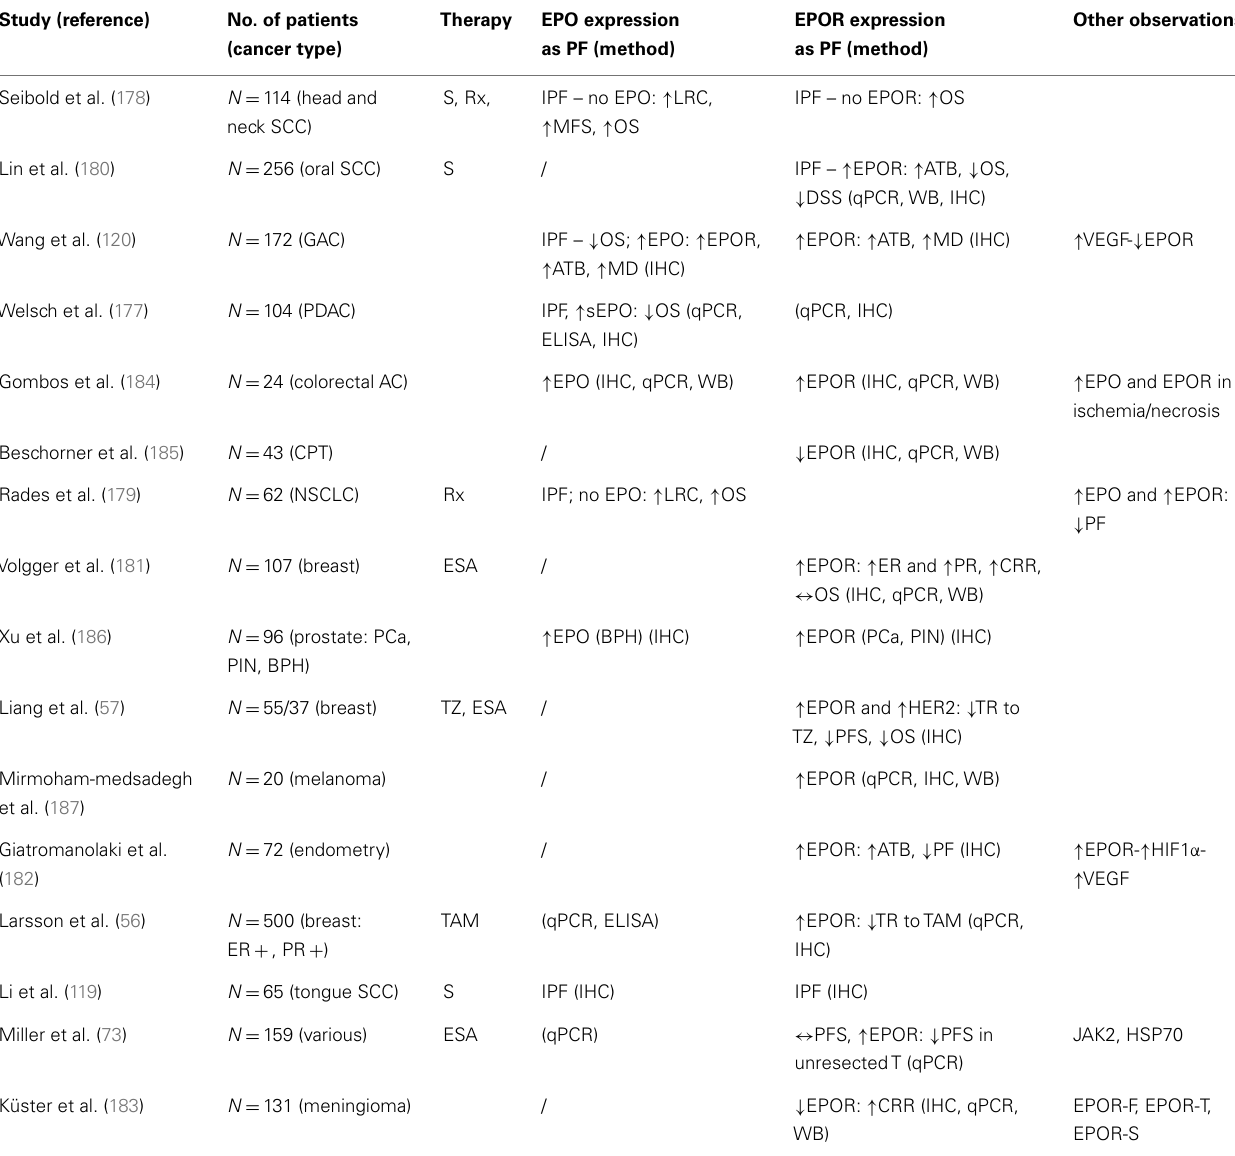
Table 2 | Clinical studies exploring prognostic significance of EPO and EPOR expression in cancer patients